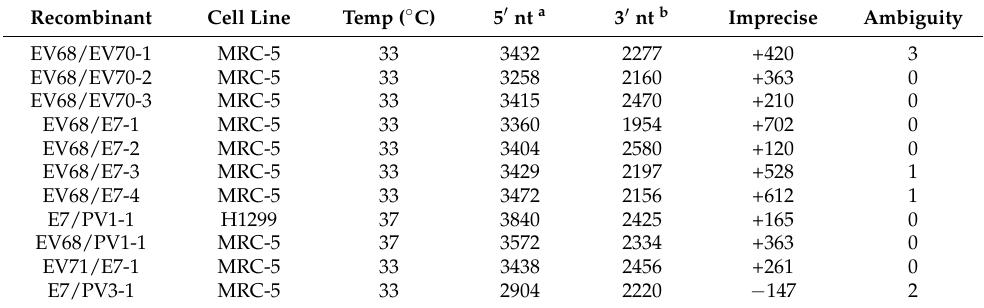
Table 2. Recombinant